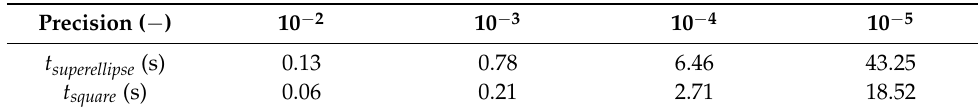
Figure 5. ( a ) Flowchart of a highly efficient packing with accurate packing fraction; ( b ) Examples of penetrable packing models with a packing fraction 𝜙 = 0.8 ± 𝑒 , where the precision 𝑒 = 10 −5 . For both generations, the particle number ( 𝑁 𝑝 = 819 ) is the same because the equivalent diameter 𝐷 𝑒𝑞 is used for non-circular particles. Table 5. The relationship between precision and elapsed